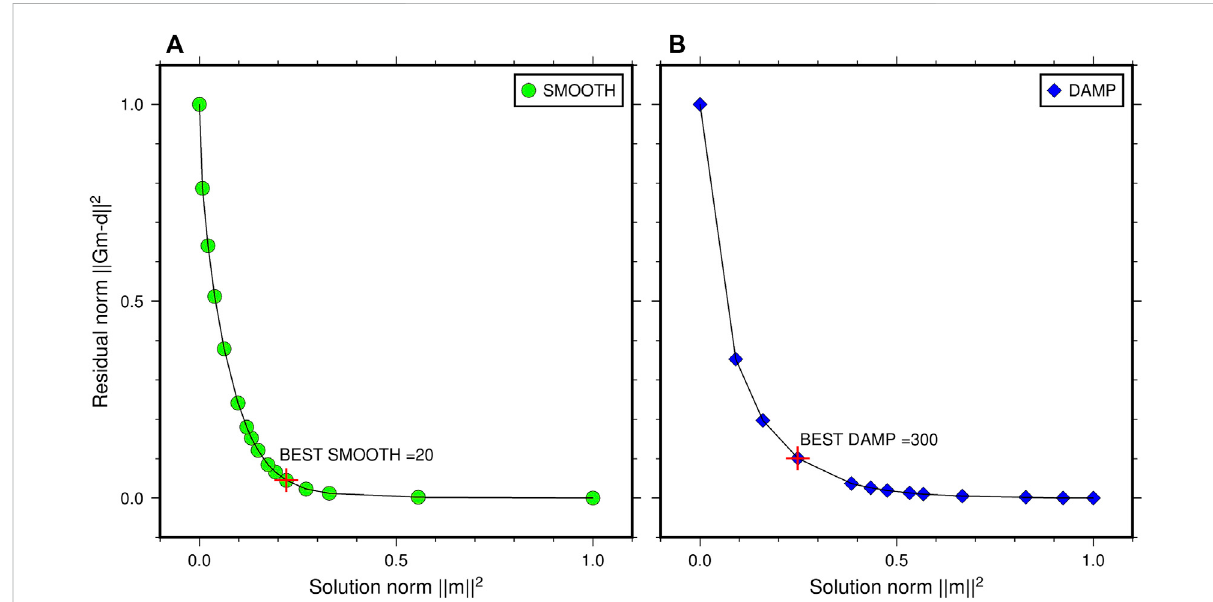
FIGURE 4 Trade-off curves of smoothing (A) and damping (B) weight parameters. The horizontal axis represents the normalized norm of slowness variation, the vertical axis represents the normalized norm of overall travel-time residual.